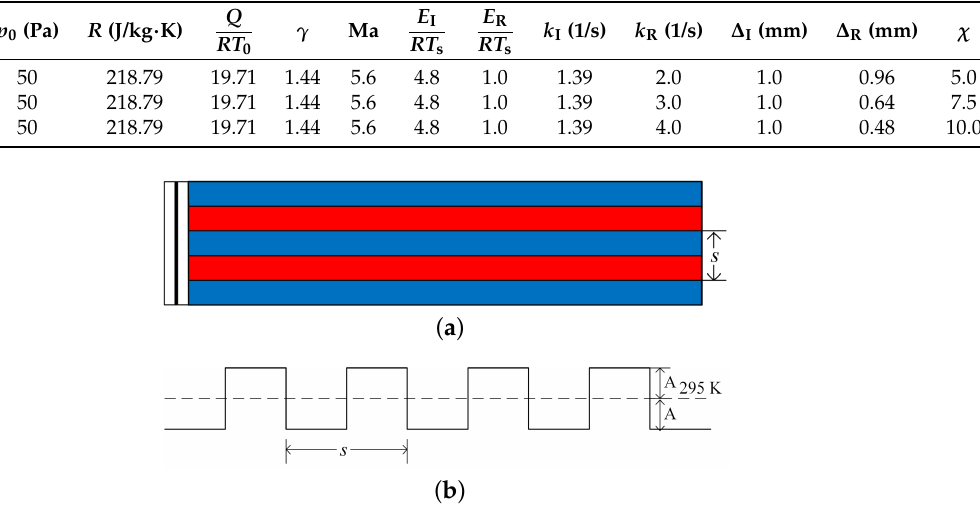
Table 1. Detonation reaction parameters.